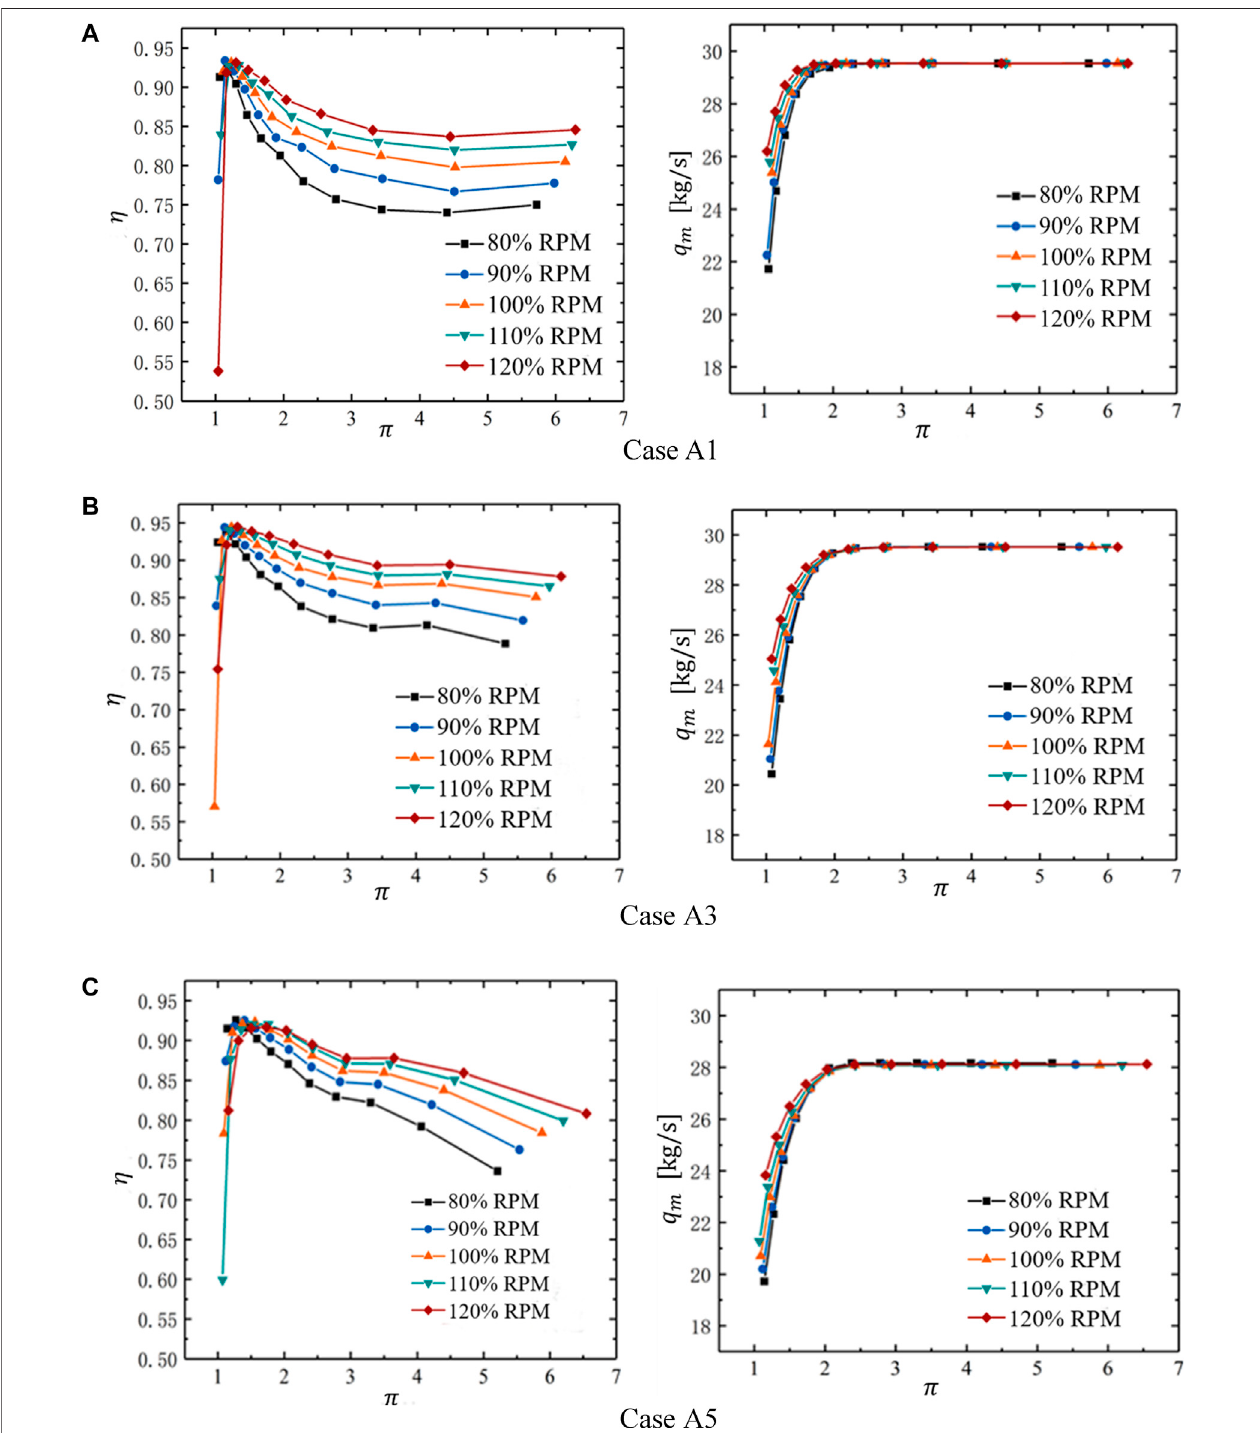
FIGURE 14 | Ef fi ciency and Mass fl ow rate characteristic line of different reaction degrees. (A) Case A1. (B) Case A3. (C) Case A5.